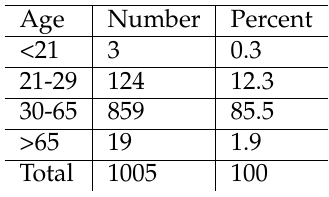
Table 1. Age distribution of subjects undergoing Pap smear examination